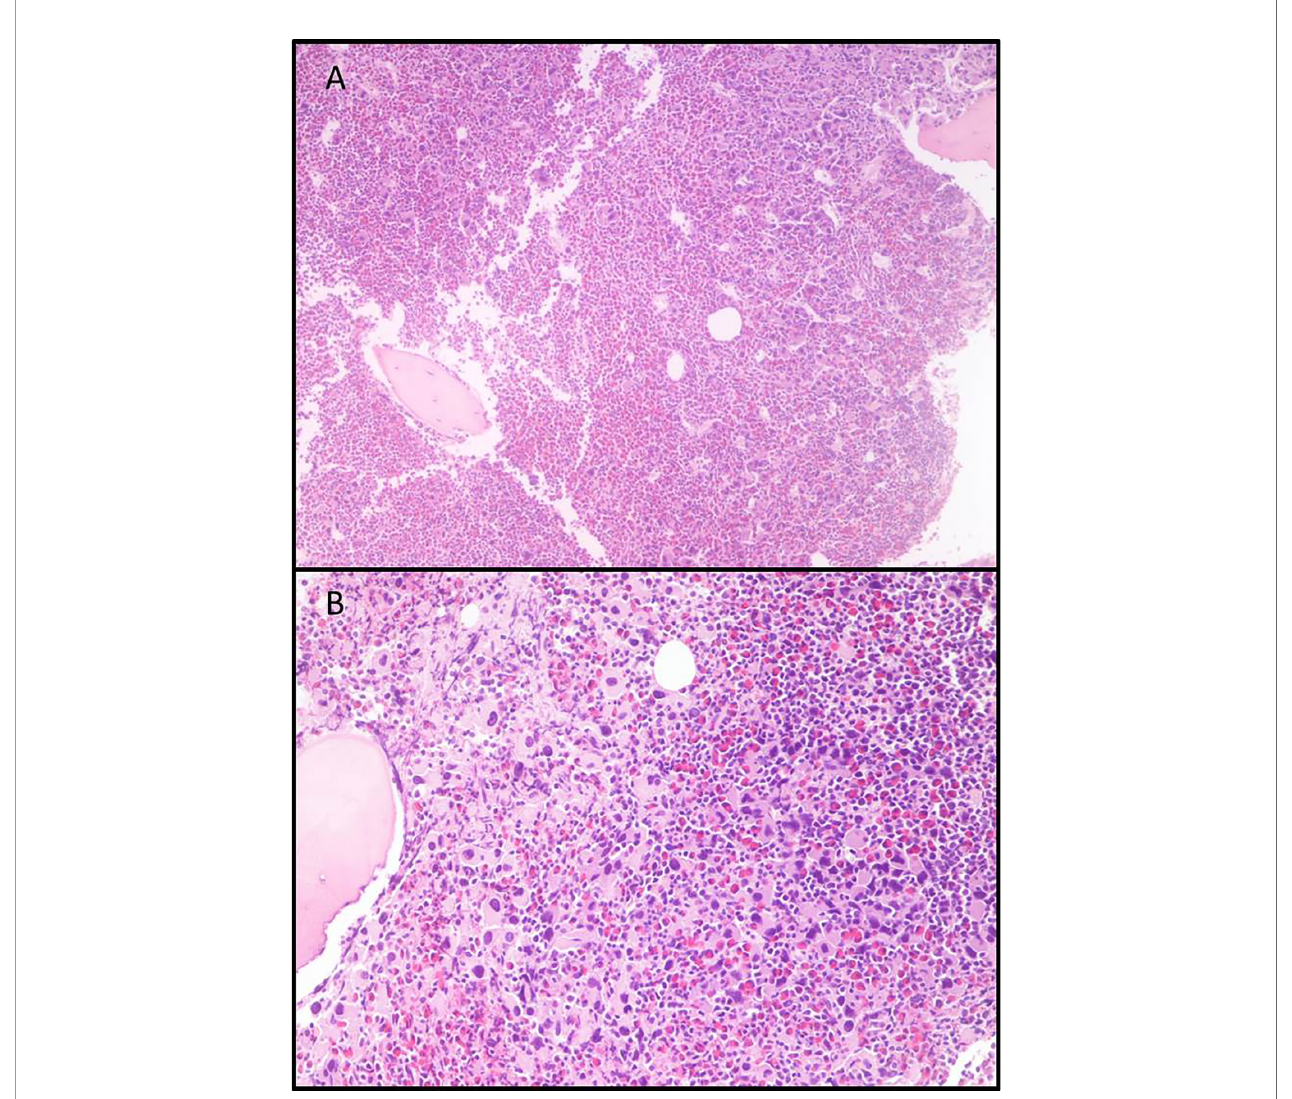
FIGURE 1 | Bone marrow biopsies. (A) Eosinophilia and micro-megakaryocyte proliferation. Evident signs of fi brosis, original magni fi cation 5×; (B) Micro- megakaryocytes characterized by hypo-lobated nuclei, original magni fi cation